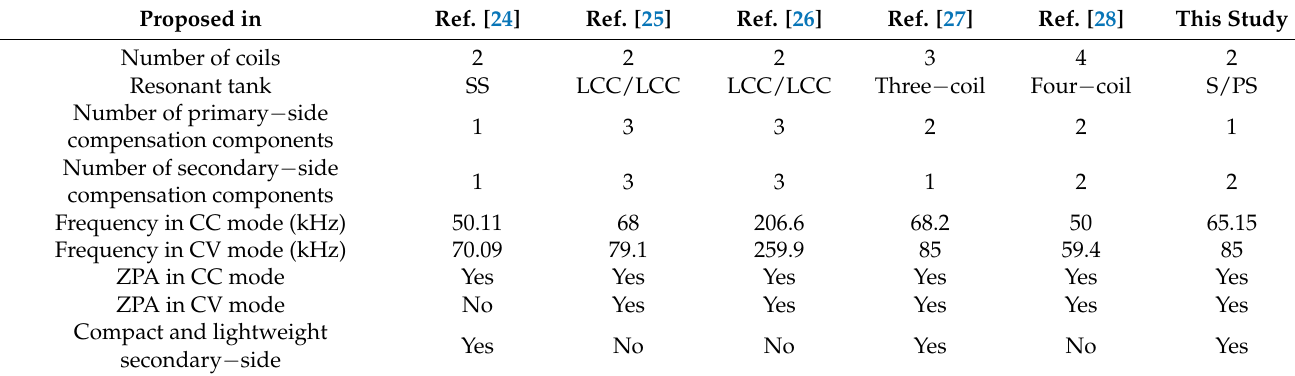
Table 4. Comparison of this study with previous similar